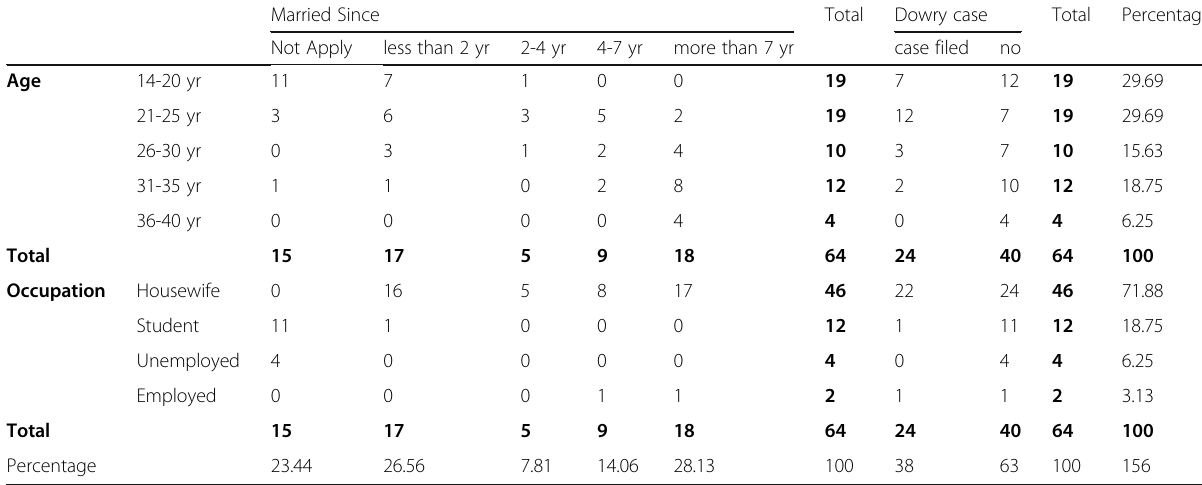
Table 2 Age and occupation wise duration of marriage and dowry case filed Married Since